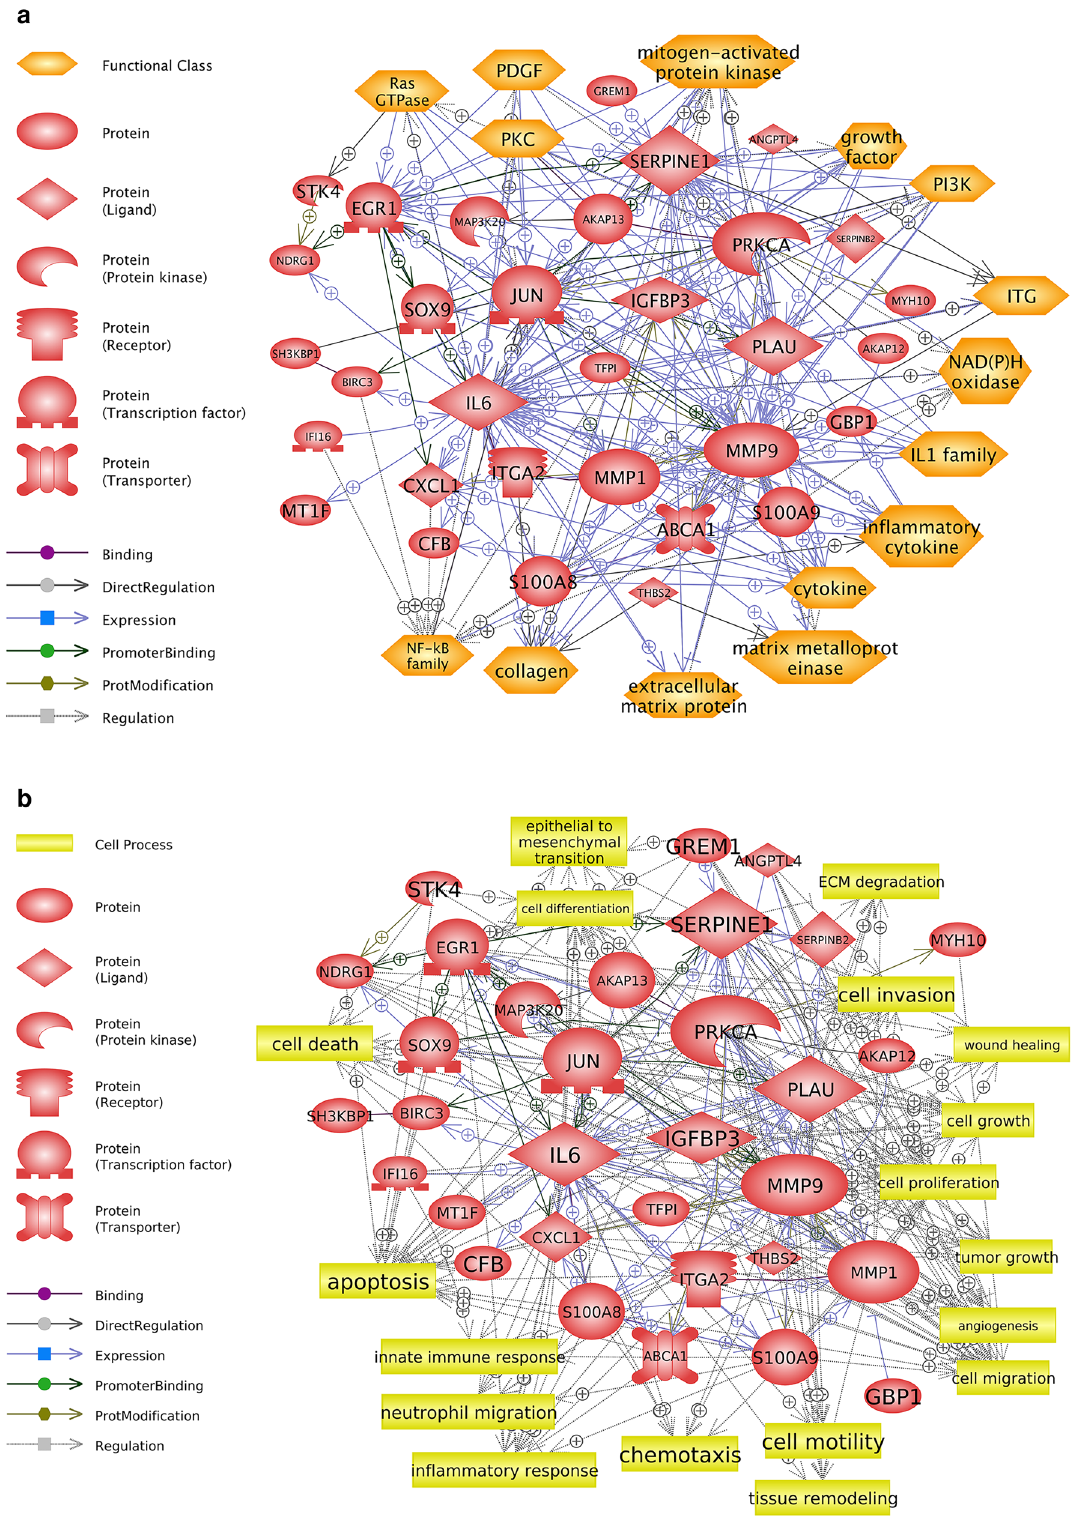
Figure 2. Potential biological signaling networks involved with PM-induced skin diseases predicted from the public data-based analysis. Direct biological interaction among the identified genes related to PM-induced skin diseases. ( a ) Biological functions of the genes predicted to be altered by signaling networks were analyzed using Pathway Studio. The predicted functions are presented as a “functional class” in the pathway. ( b ) Cellular processes predicted to be affected by signaling networks among the identified genes were analyzed using Pathway Studio. The descriptions of the schematic symbols are located to the left of each